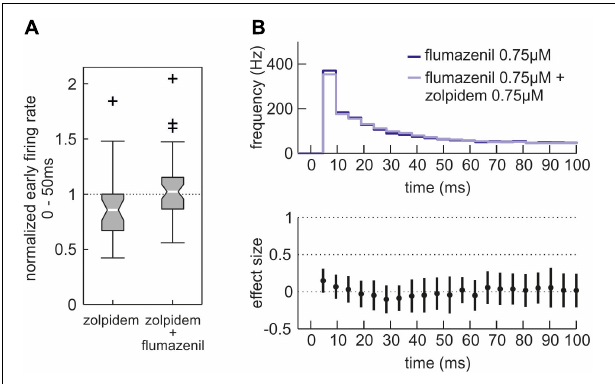
FIGURE 7 | Effects of zolpidem in the additional presence of the benzodiazepine antagonist flumazenil. (A) Action of zolpidem (0.75 µ M) in the absence and presence of flumazenil (0.75 µ M) given as boxplot. While depression of high neuronal activity (0 – 50 ms after initiation of up state) by zolpidem is evident (left side, n = 30, median = 0.86, iqr = 0.33 of normalized activity) it is absent in the additional presence of flumazenil (right side, n = 47, median = 1.02, iqr = 0.29 of normalized activity, p = 0.0147, Mann–Whitney U -test). (B) Action of zolpidem (0.75 µ M) in the presence of flumazenil (0.75 µ M) given as PETH, with the dark blue curve showing the neuronal activity in the sole presence of flumazenil and the light blue curve showing a combined application of flumazenil and zolpidem. Within the first 100 ms after the beginning of neuronal up states the depressant action of zolpidem is absent in the additional presence of